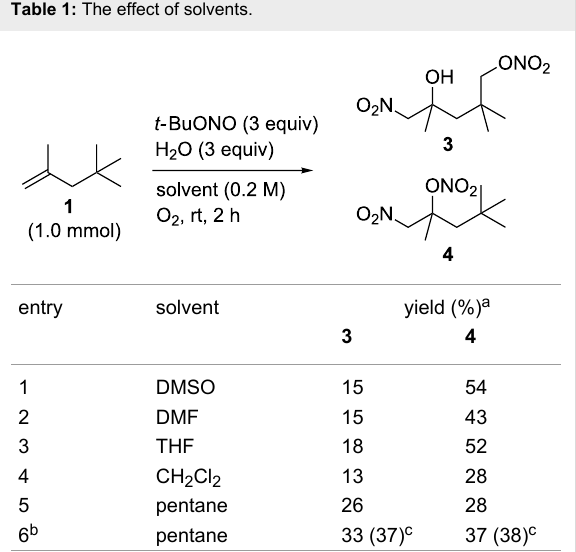
Table 1: The effect of